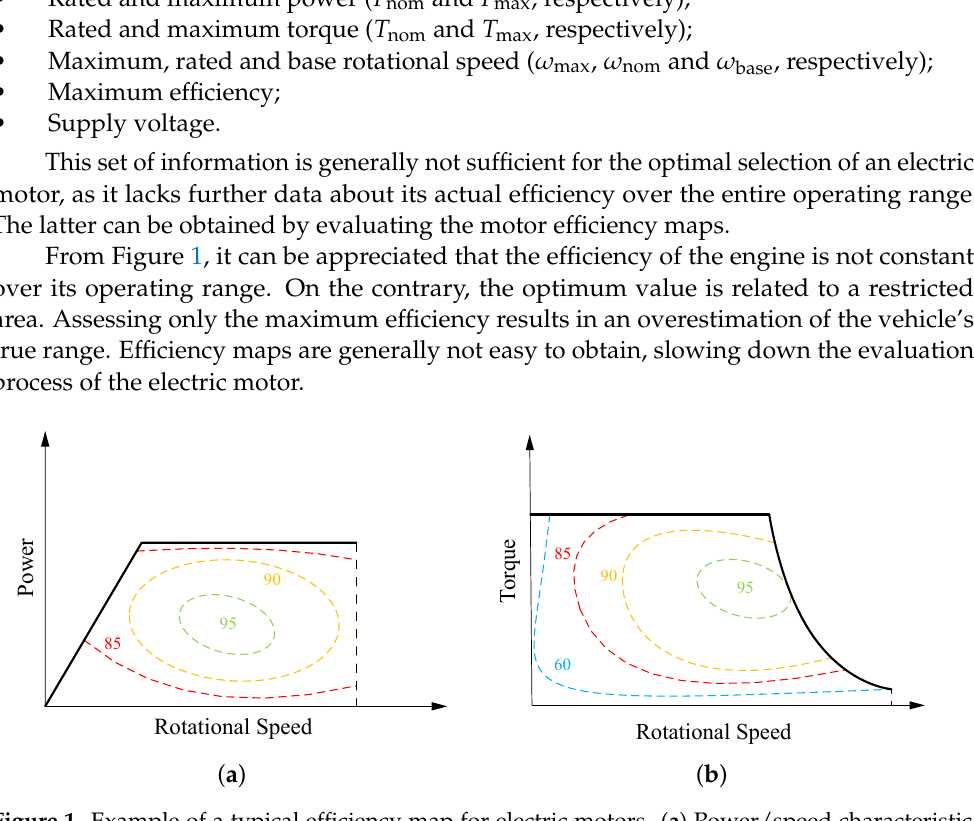
Figure 1. Example of a typical efficiency map for electric motors. ( a ) Power/speed characteristic. ( b ) Torque/speed